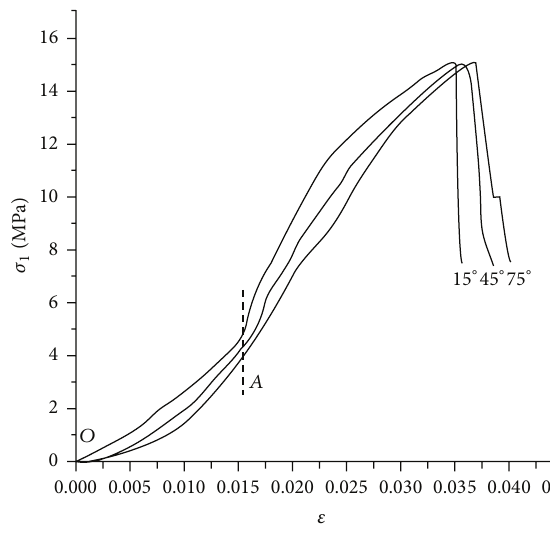
Figure 6: Vertical axial stress versus strain under unloading.